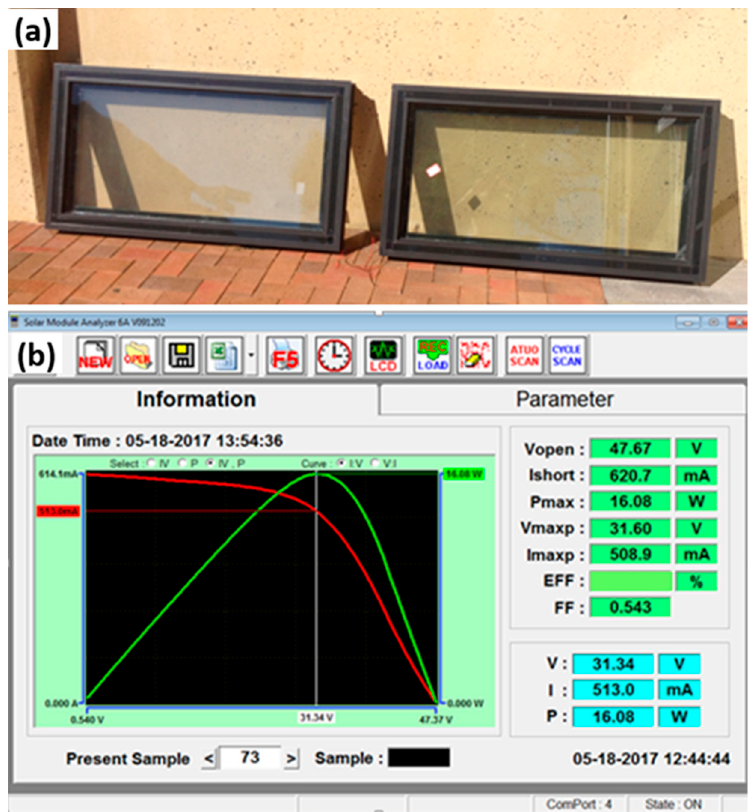
Figure 5. Solar windows constructed using glass panel dimensions of 1200 mm × 600 mm and their electric output performance measured outdoors in autumn conditions. ( a ) Factory-assembled solar window samples and ( b ) Measured I-V curve data.